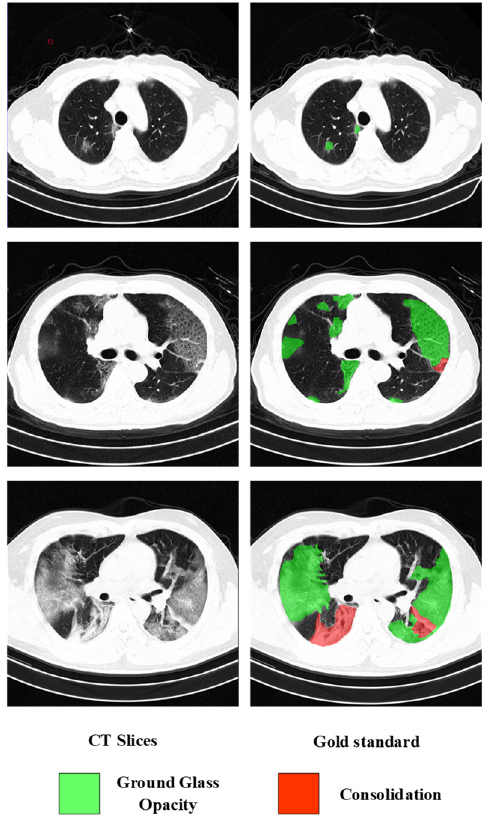
Figure 3. Three examples of CT images of different severity.